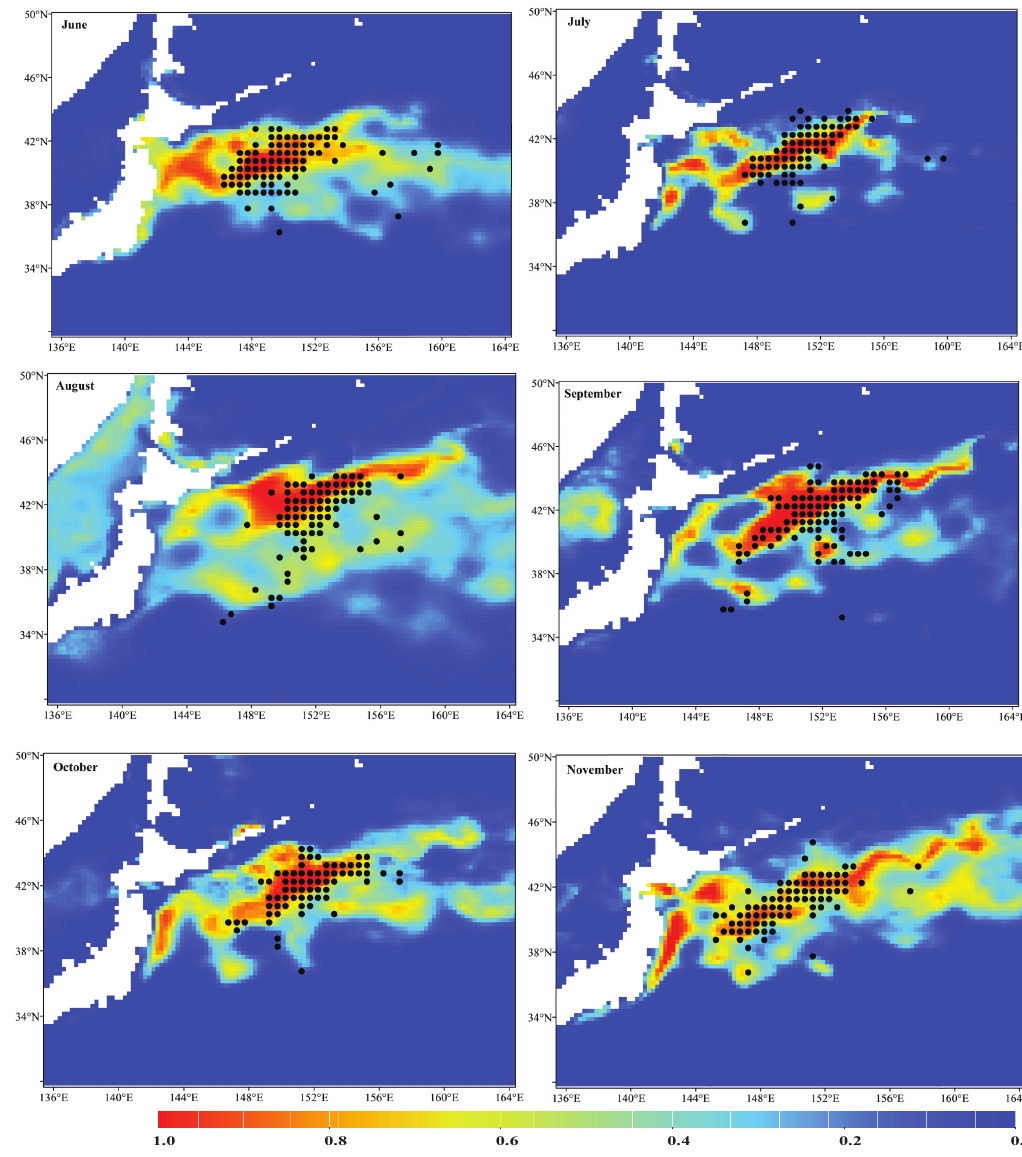
Figure 3. Predicted potential habitat distribution of the Pacific sardine in the NPO using the top single-algorithm model (MaxEnt) with the highest AUC value between June and November from 2015 to 2020. The black points represent the operation positions of the Pacific sardine fishing grounds.